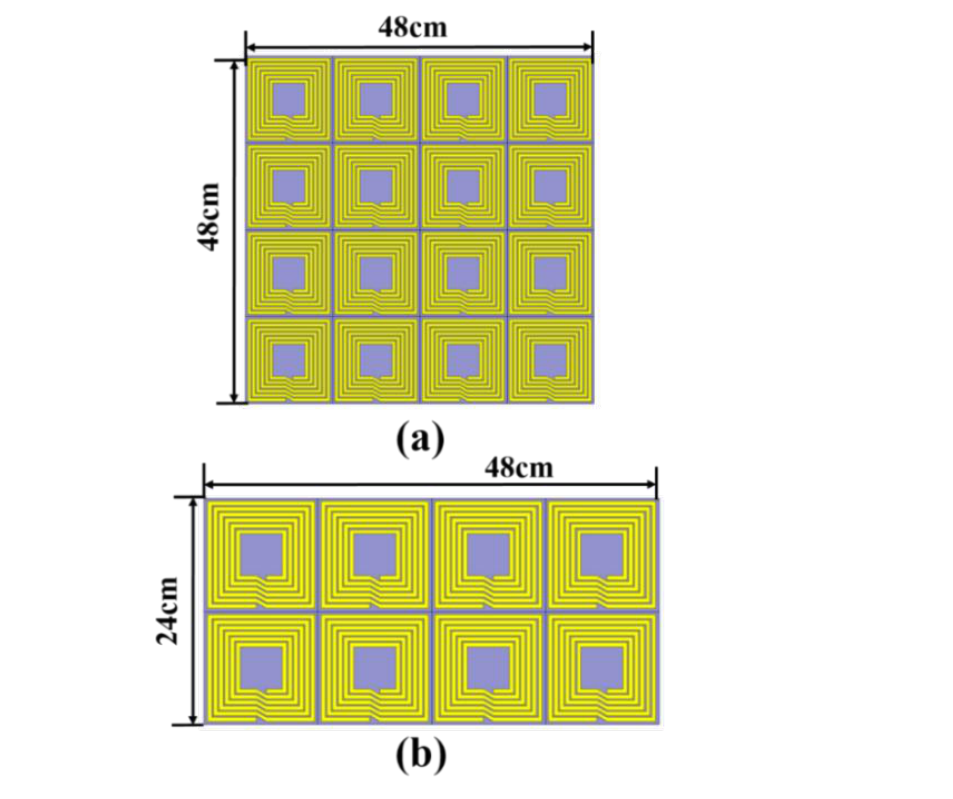
Figure 5. Fabricated structure of the proposed two matrix shielding metamaterials: ( a ) top – side